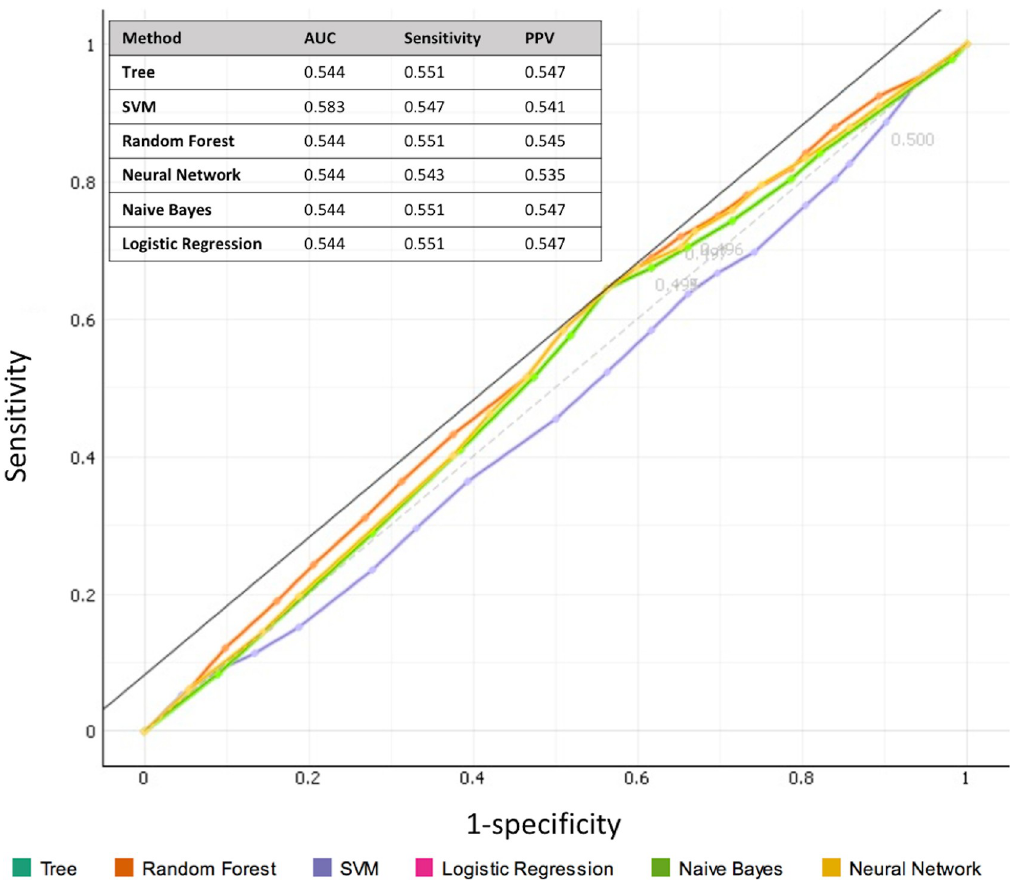
Fig 2. Evaluation of diagnostic value of the EMA sepsis criteria using data mining methods. Area under the curve [AUC], sensitivity, positive predictive value [PPV] scores and ROC curves evaluated by decision tree, support vector machine (SVM), random forest, naive-bayes, neural network, and logistic regression algorithms are